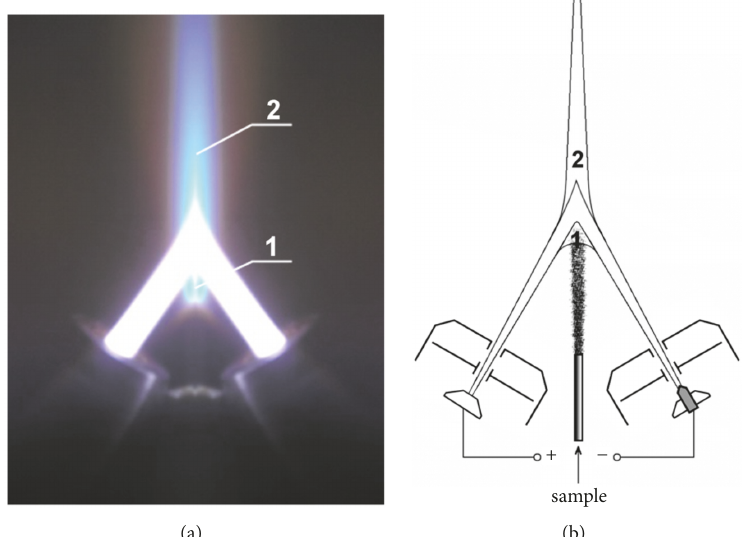
Figure 1: Plasma torch (a); electrode unit and analytical regions of the plasma flow (b): 1, before the jet confluence; 2, after the jet confluence.